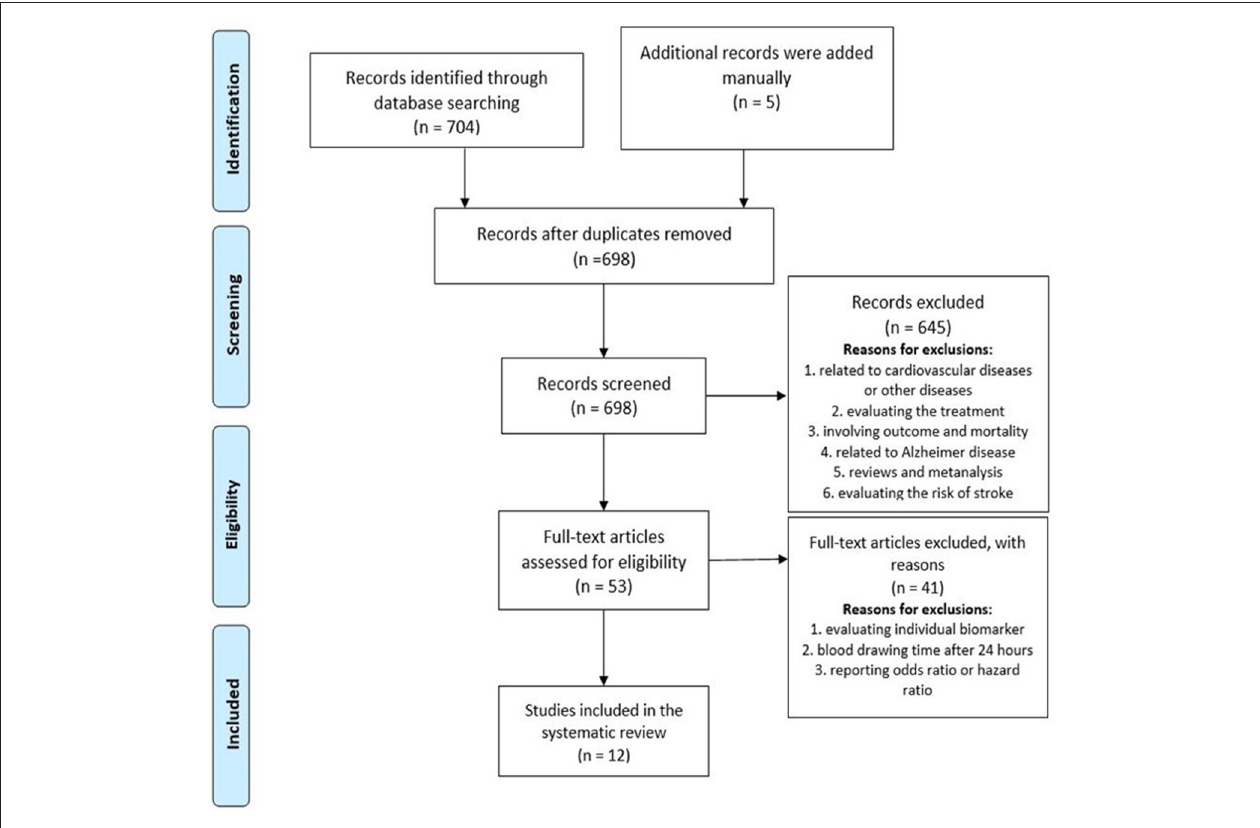
FIGURE 3 | PRISMA diagram. Flow diagram of the search and screening process. PubMed research yielded 704 articles at baseline, and five were added manually. No other sources of article identification were identified.